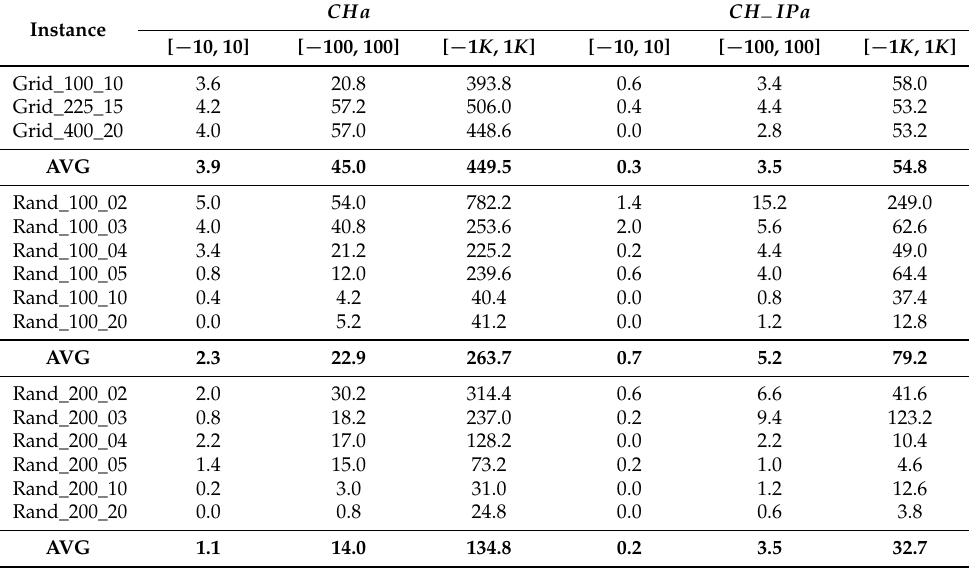
Table 2. Absolute objective function values obtained—instances with random